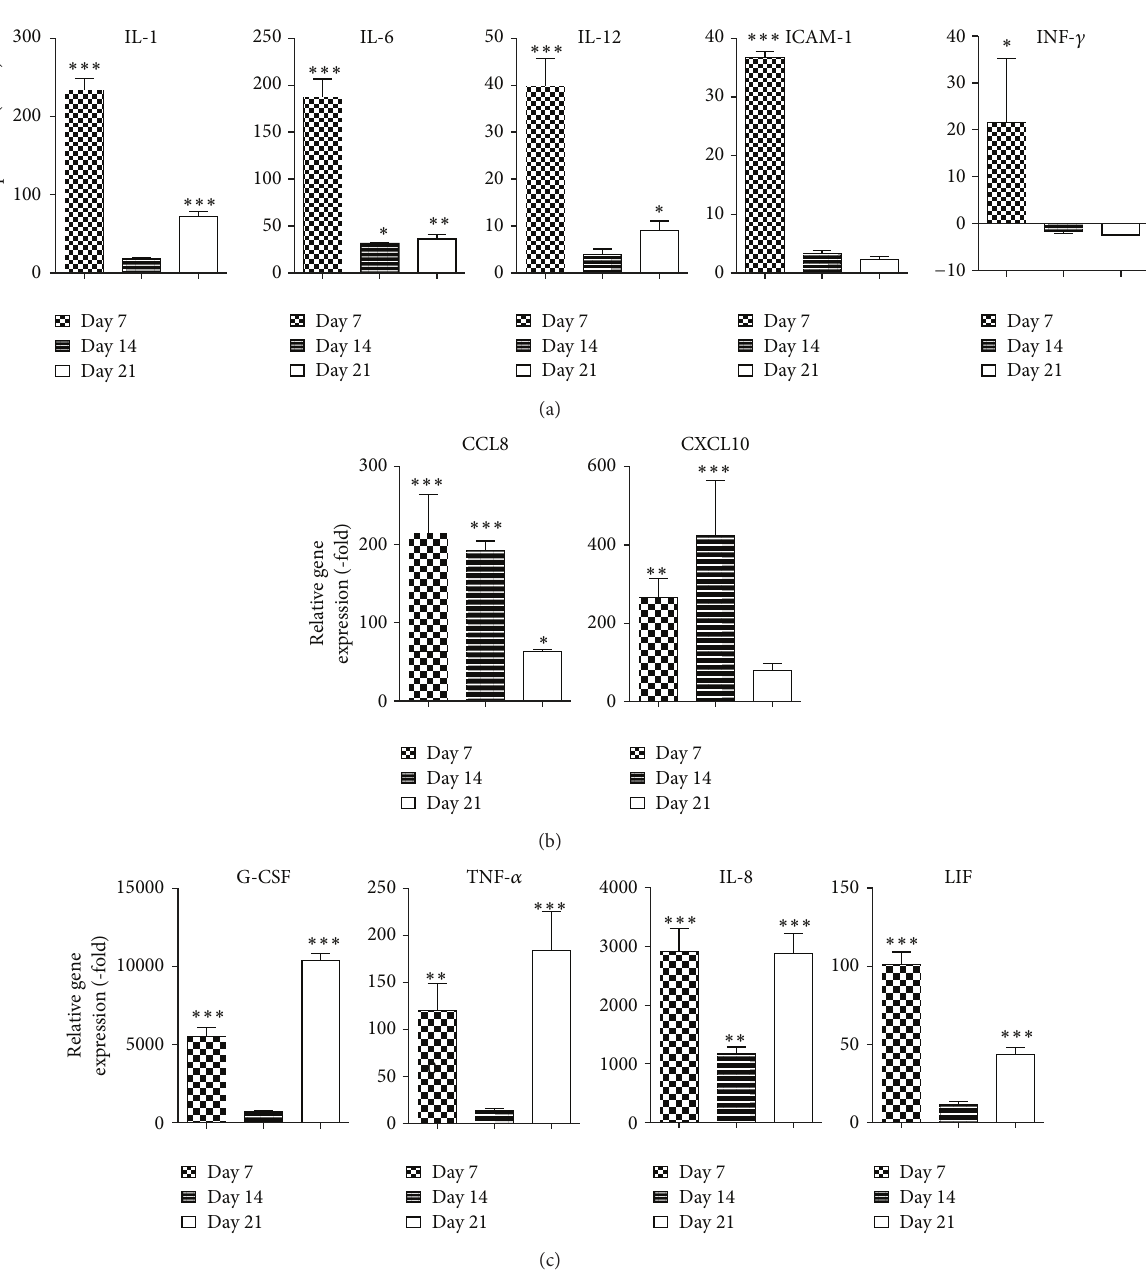
Figure 2: Proinflammatory cytokines are upregulated during osteogenic differentiation of ASCs. ASCs were cultured in CCM and changed to ODM. Cells were harvested on days 7, 14, or 21 and analyzed by qRT-PCR. Data is normalized to undifferentiated cells. Mean ± SEM. ∗ 𝑃 < 0.05 ; ∗∗ 𝑃 < 0.01 ; ∗∗∗ 𝑃 < 0.001 relative to undifferentiated cells.